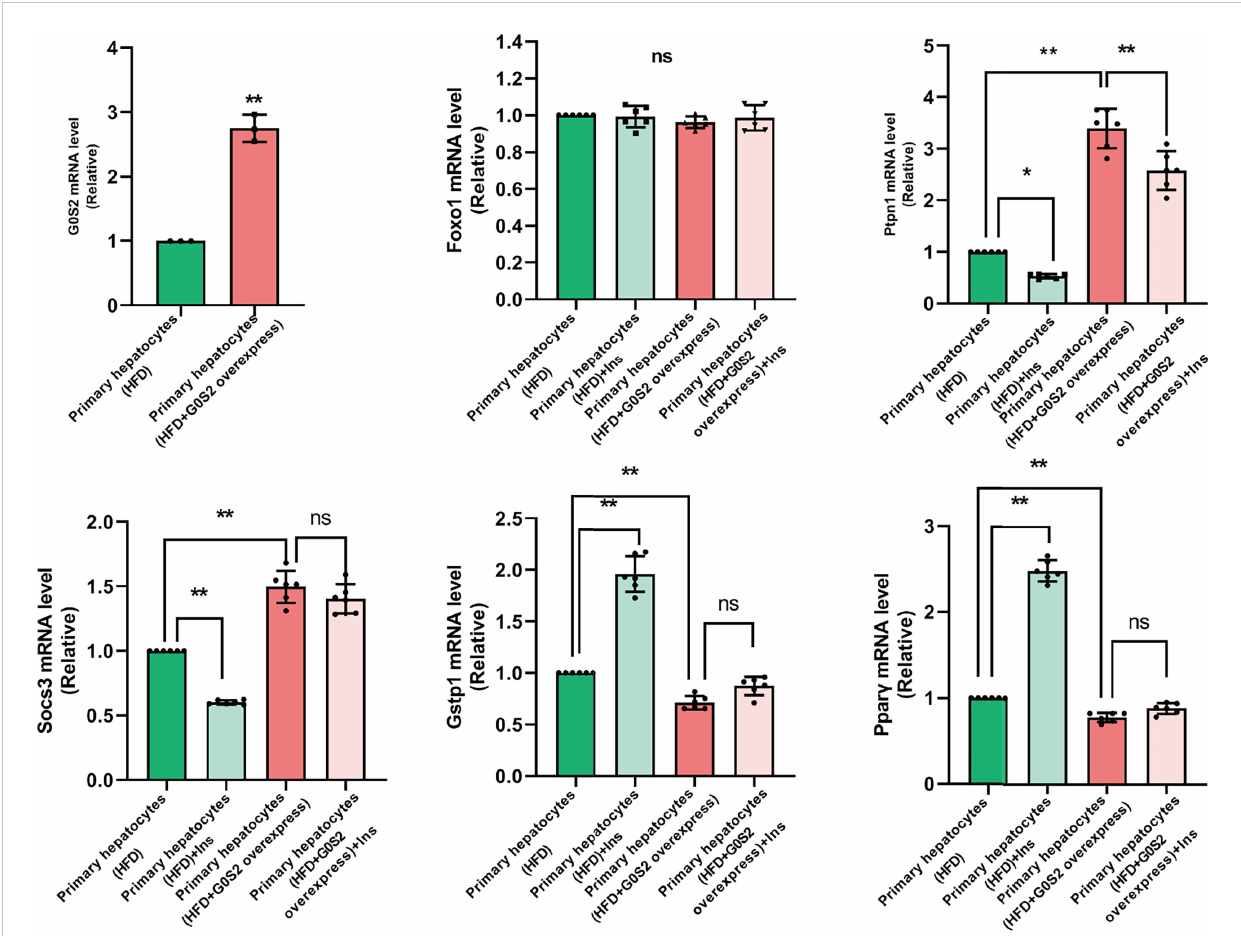
FIGURE 7 The genes involved in insulin resistance were evaluated using RT-PCR analysis in primary mouse hepatocytes. Downregulation of the phosphatases Foxo1, Socs3, and Ptpn1, as well as upregulation of Gstp1 and PPAR- g , were determined in primary mouse hepatocytes isolated from G0S2 - overexpressing mice (HFD+G0S2 overexpression) by RT-PCR. *P<0.05, **P<0.01. ns,